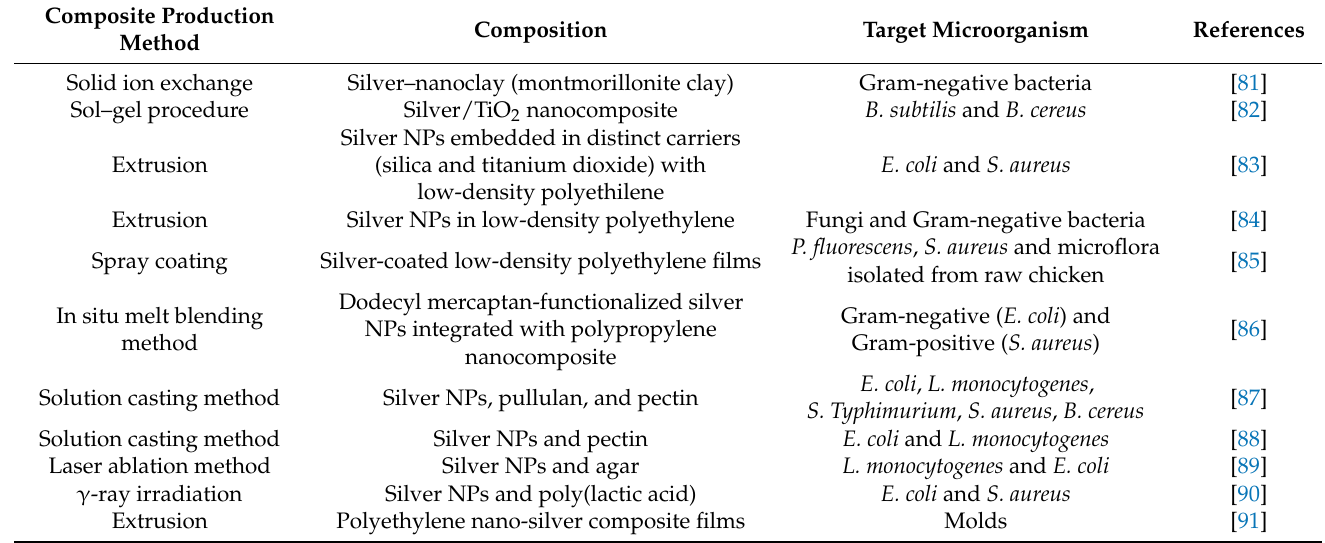
Table 2. Applications of silver NPs for food